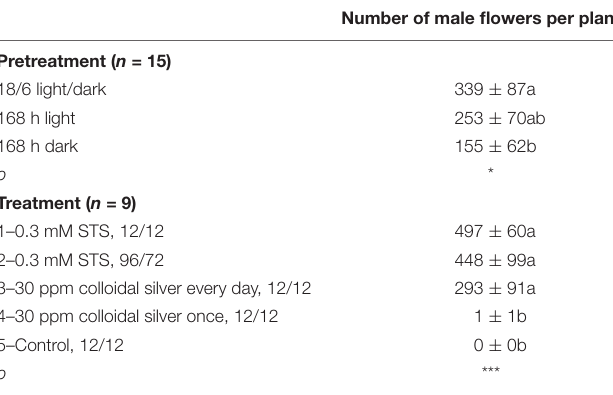
TABLE 4 | Influence of pretreatment and treatment on a number of male flowers per plant of MX-CBD-707. Number of male flowers per